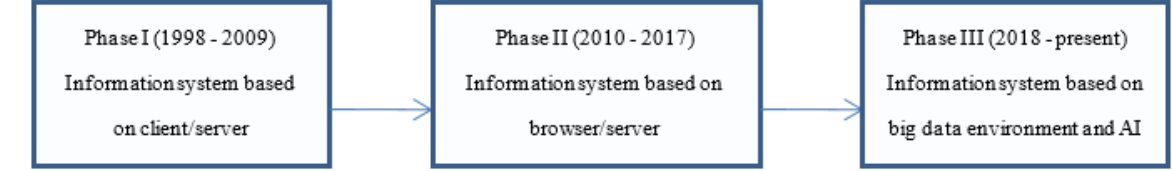
Figure 1. The three phases of the development of China’s medical insurance information systems (MIISs).